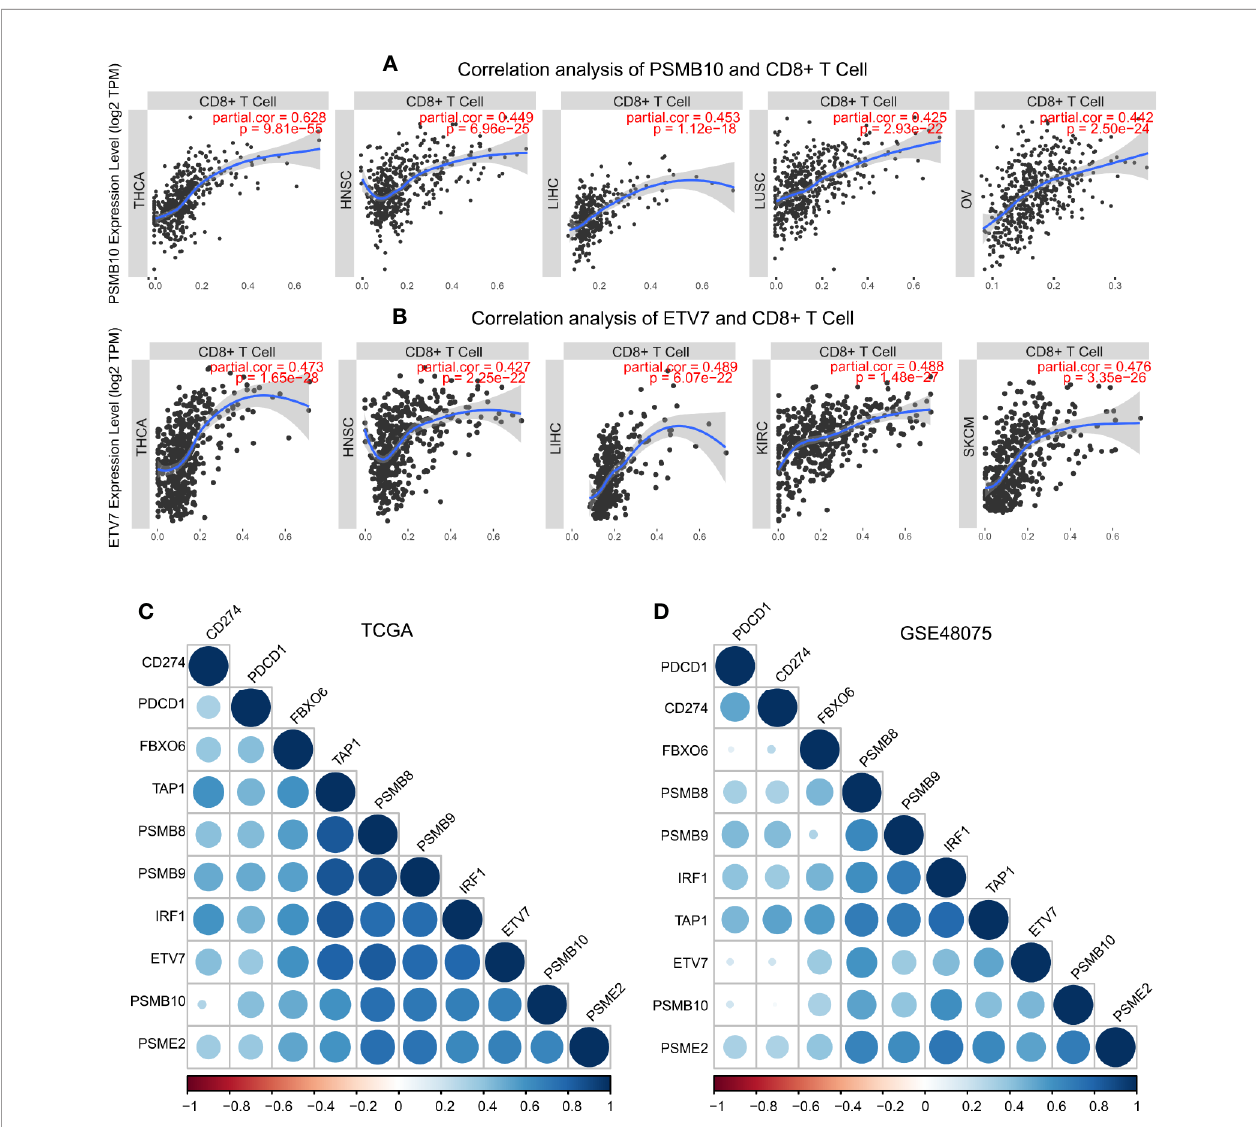
FIGURE 10 | Pan-cancer analysis of PSMB10 and ETV7. (A) Correlation analysis of PSMB10 and CD8 + T cells. (B) Correlation analysis of ETV7 and CD8 + T cells. (C, D) PD1/PDL1 correlation analysis. A positive correlation was found between CD8 + T cells and PD1/PDL1 in TCGA and